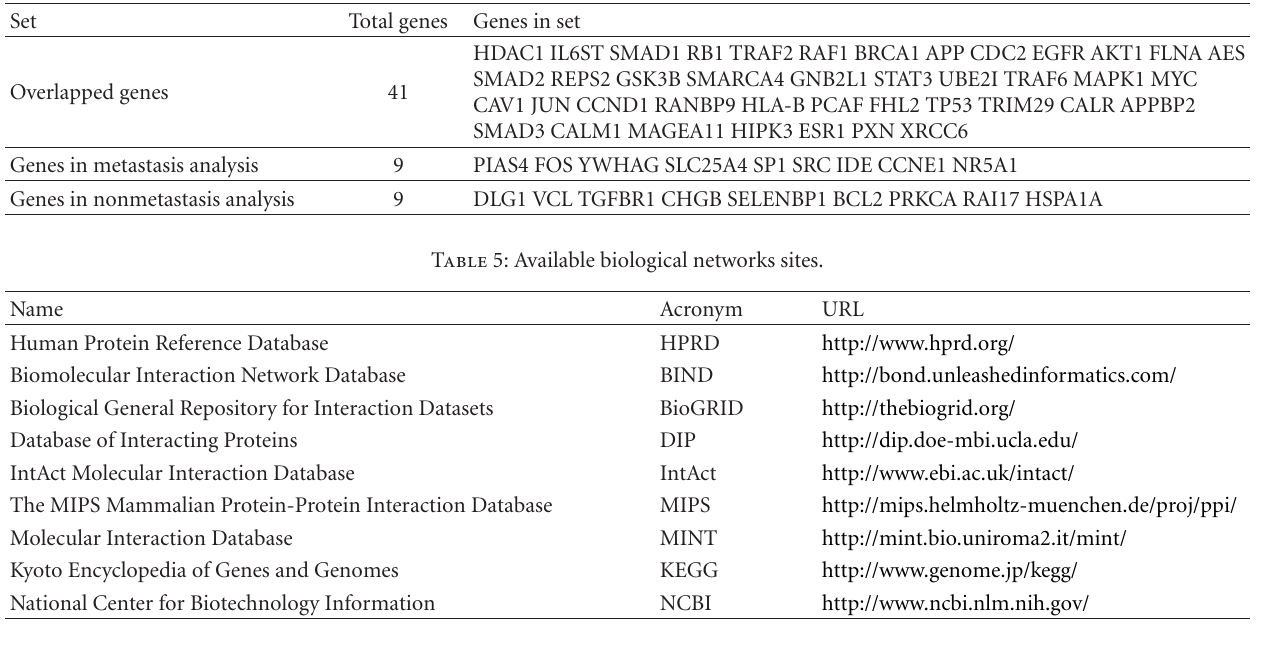
Table 4: Top 50 genes overlap.